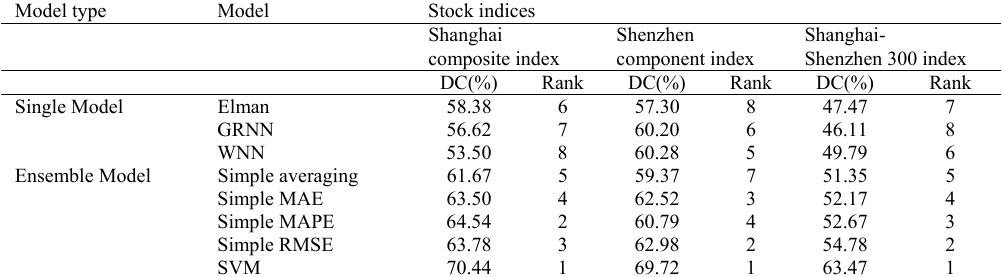
Table 5. Comparison of performance of DC averaging each model over 20 runs.